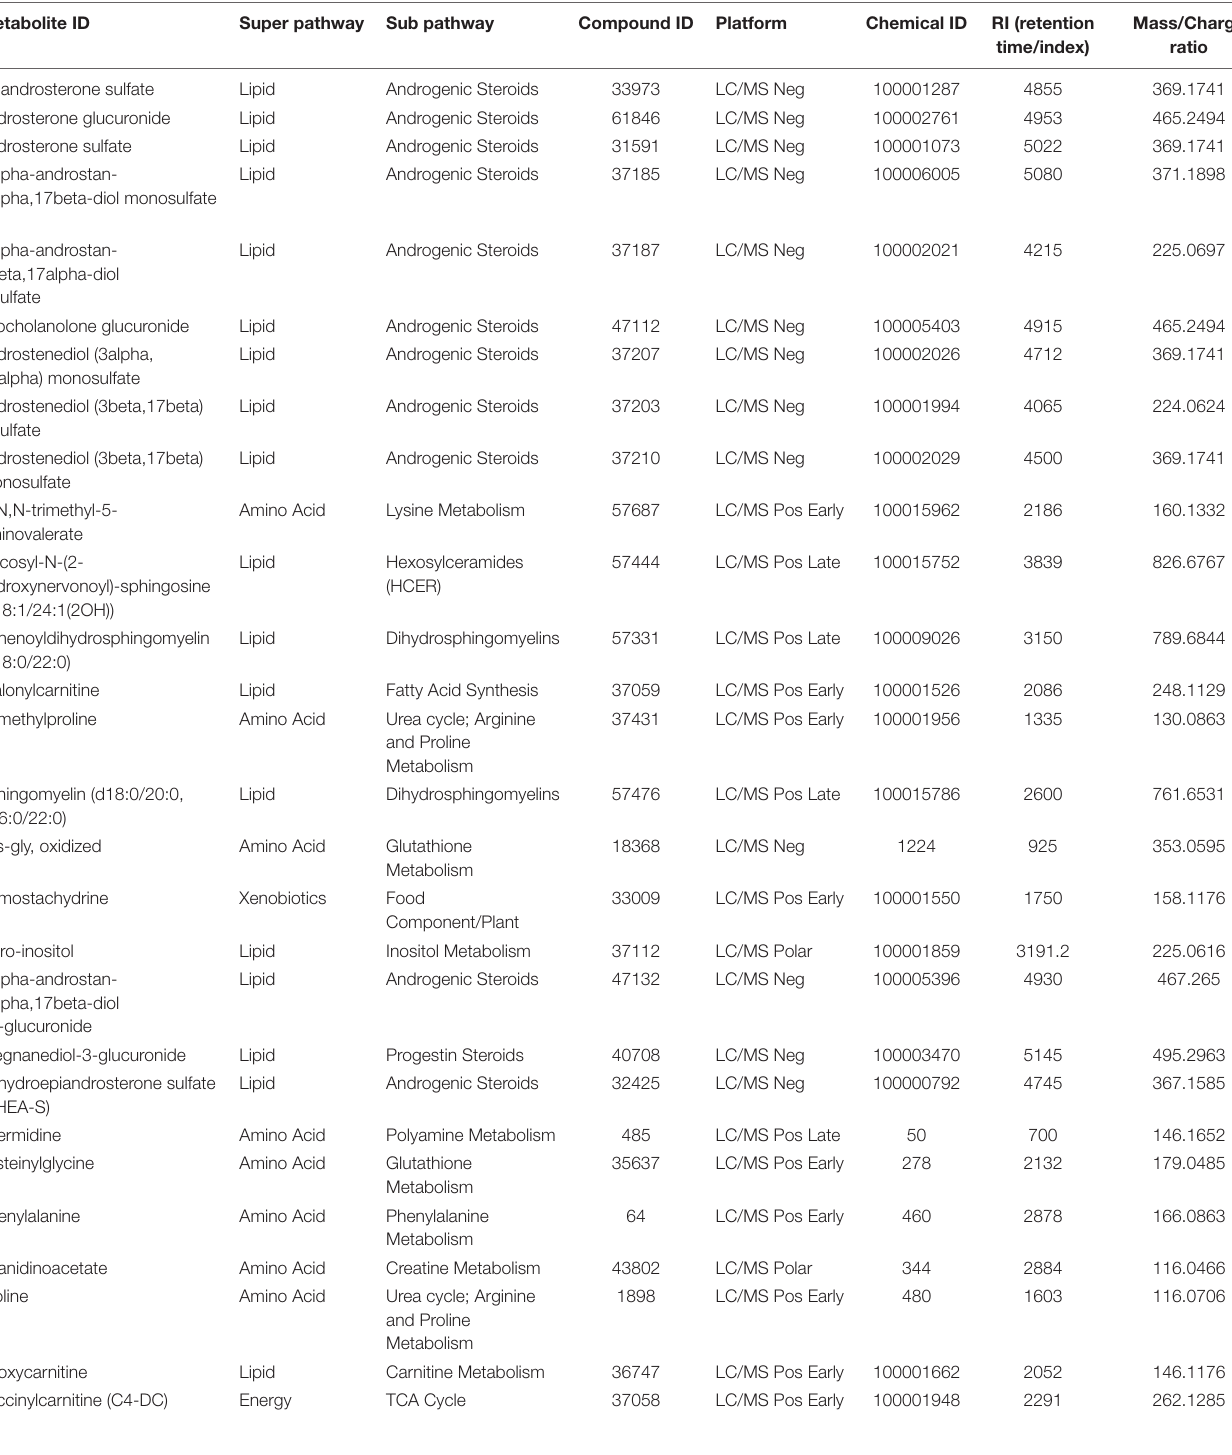
TABLE 2 | Chemical information of metabolites of